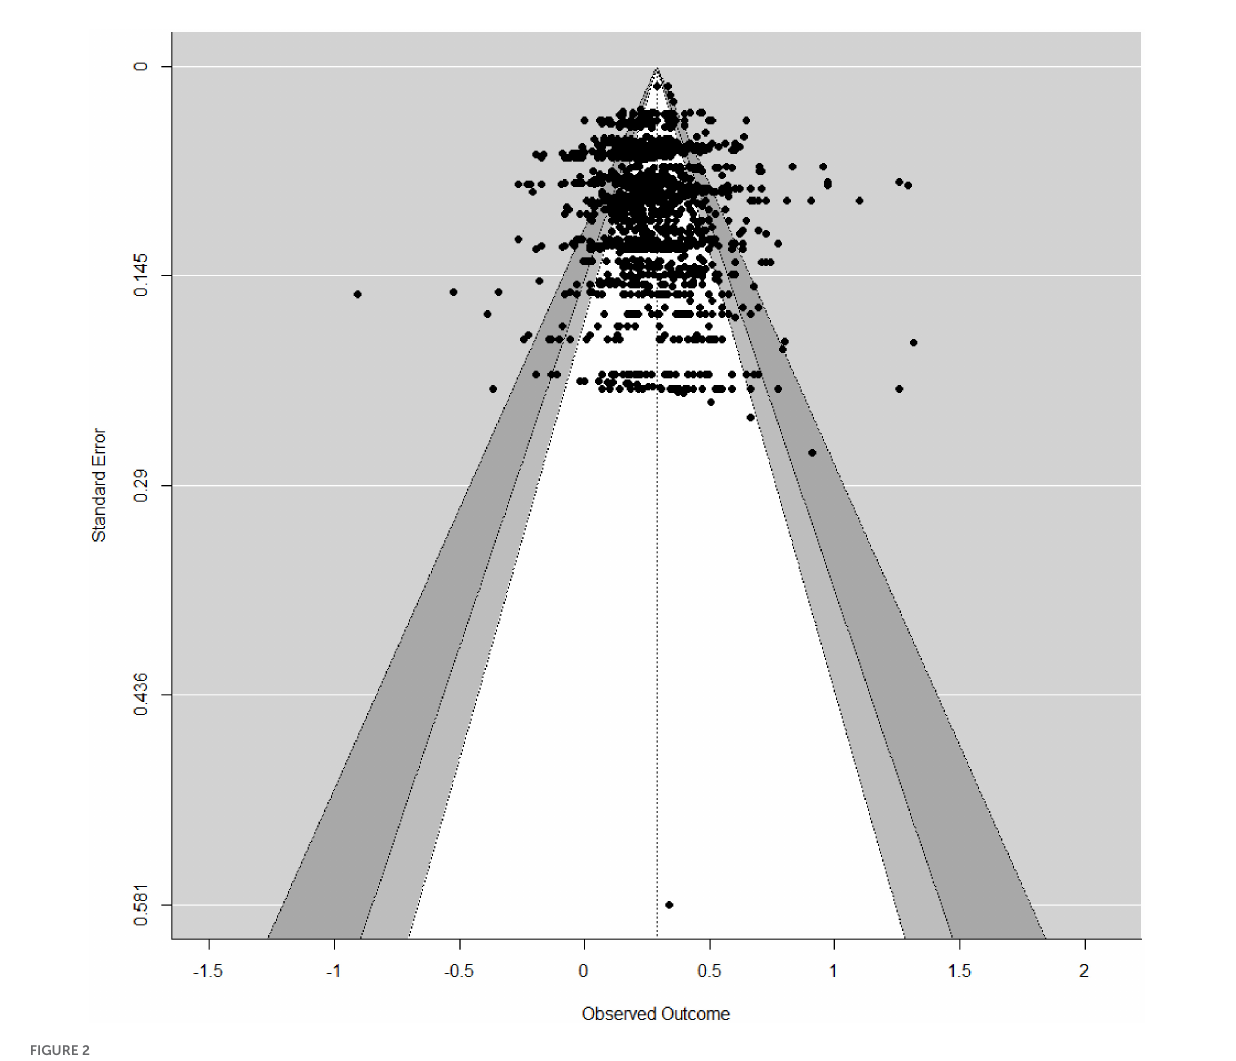
FIGURE2 Funnel plot of the overall mean r